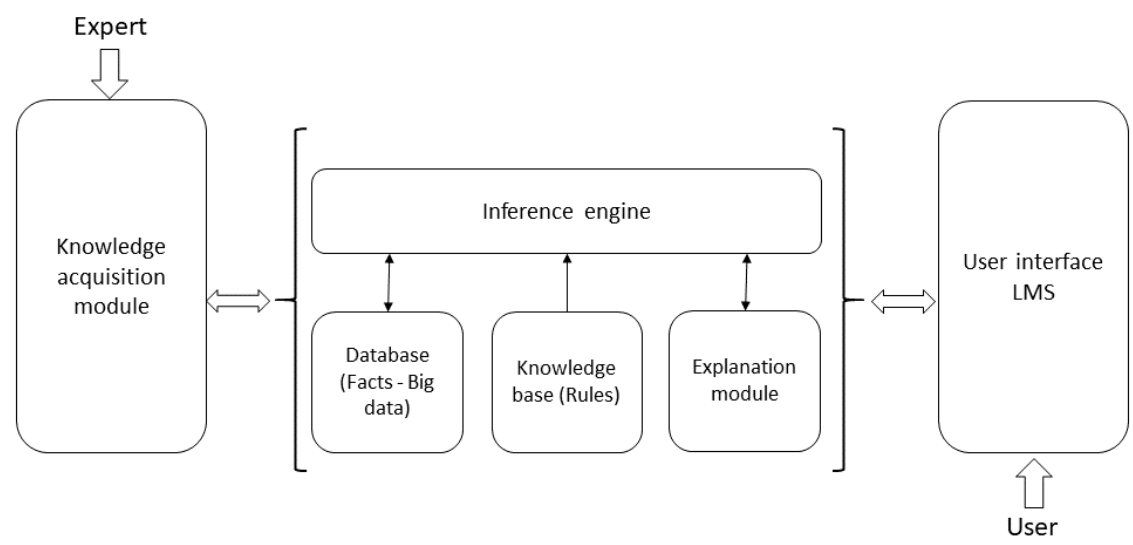
Figure 5. Components of the architecture of an expert system used for the recommendation of activities.